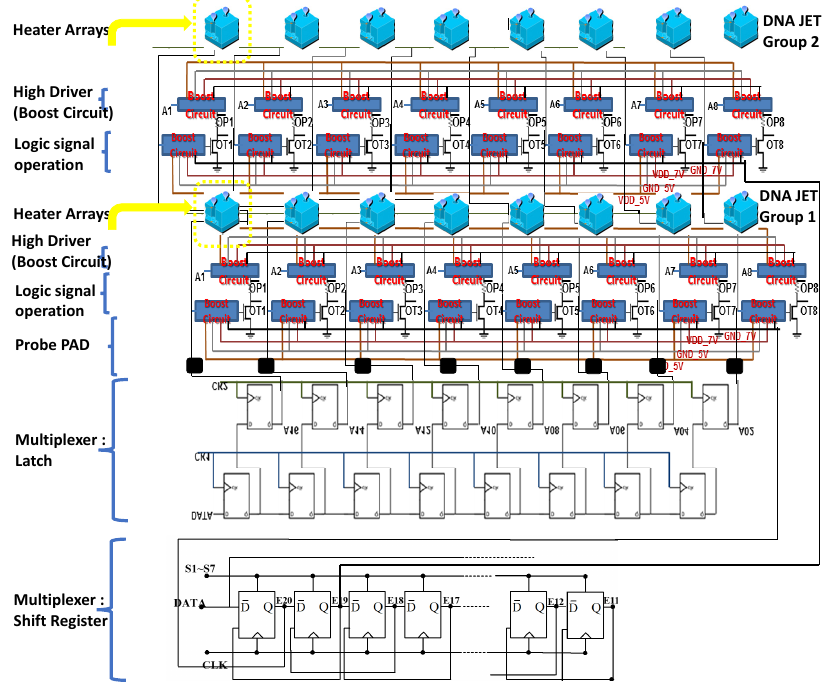
Figure 2. Serial input parallel output shift registers forms of